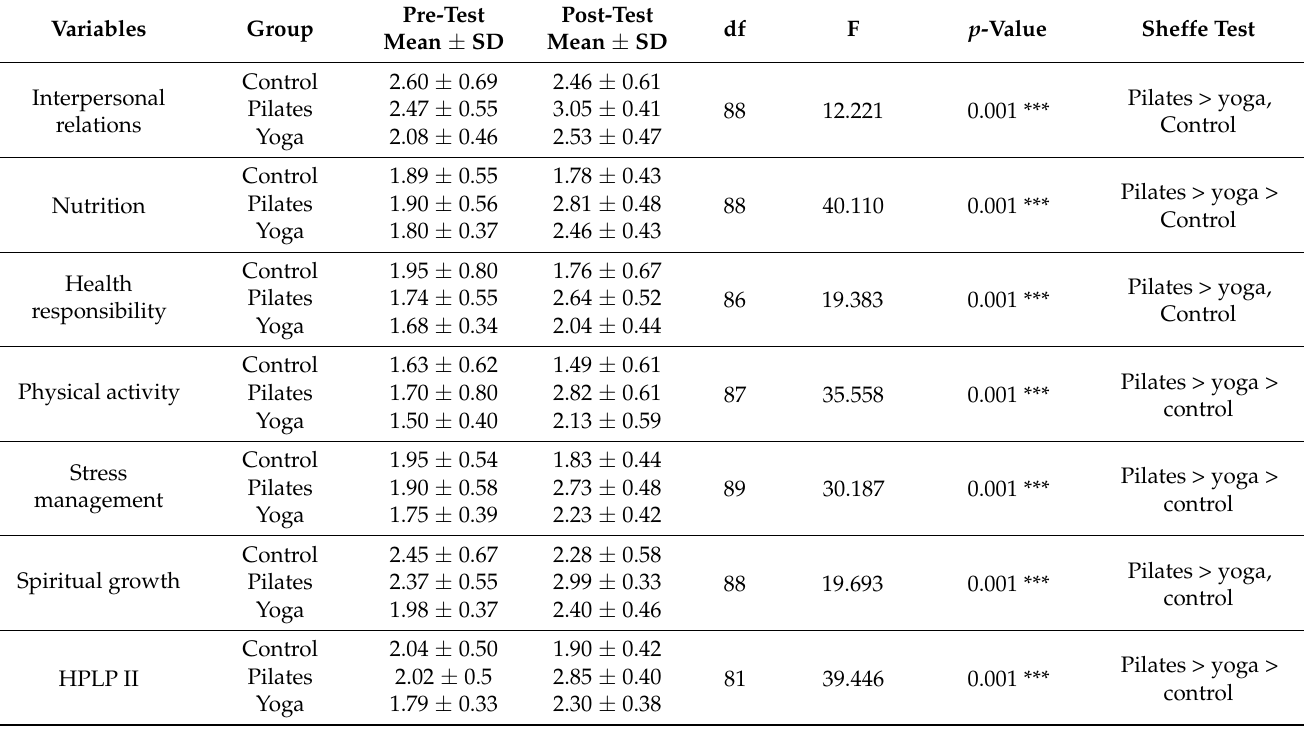
Table 4. Pre- and post-treatment HPLP II across the three groups.